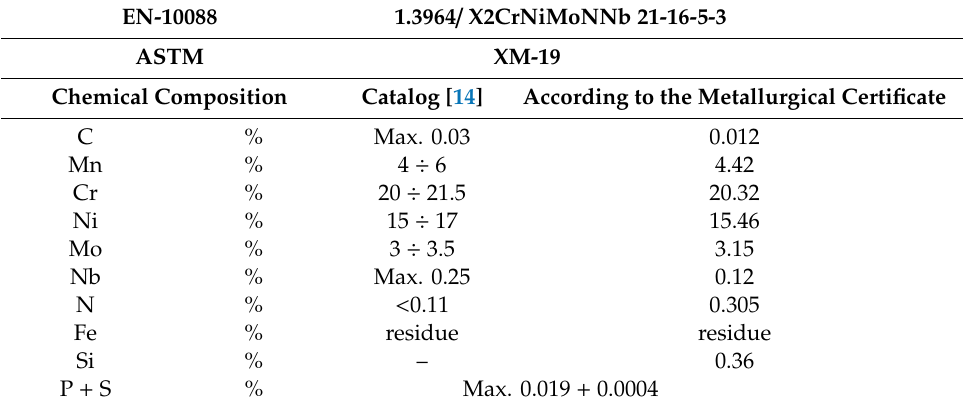
Table 1. Chemical composition of 1.3964 steel